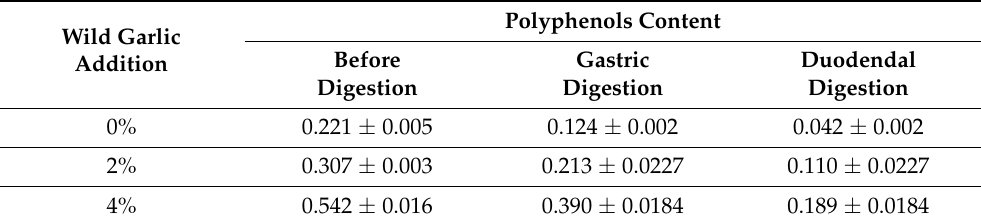
Table 5. The total content of polyphenolic compounds (TPC mg GAE/g d.w.) in snacks enriched with wild garlic before and after two-stage digestion (n = 3; mean ± SD). Polyphenols Content Wild Garlic Before Gastric Duodendal Addition Digestion Digestion